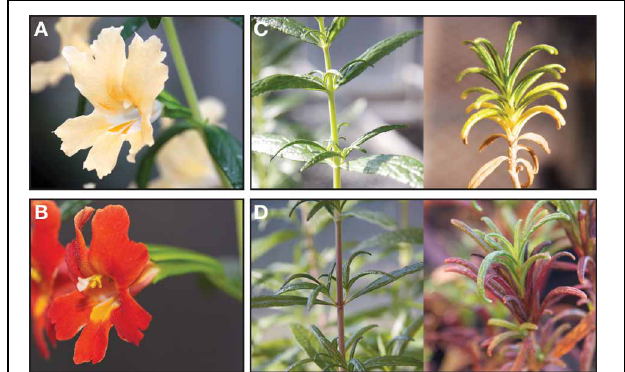
FIGURE 3 | An example of a gain in floral anthocyanin via co-option of an R2R3-MYB in Mimulus aurantiacus . (A) The yellow flowers of M. australis contain no detectable anthocyanin in floral tissue. (B) A cis -regulatory mutation in MaMyb2 causes the derived red-flowered phenotype observed in M. puniceus , and strong divergent selection on flower color by pollinators has driven the fixation of the red and yellow